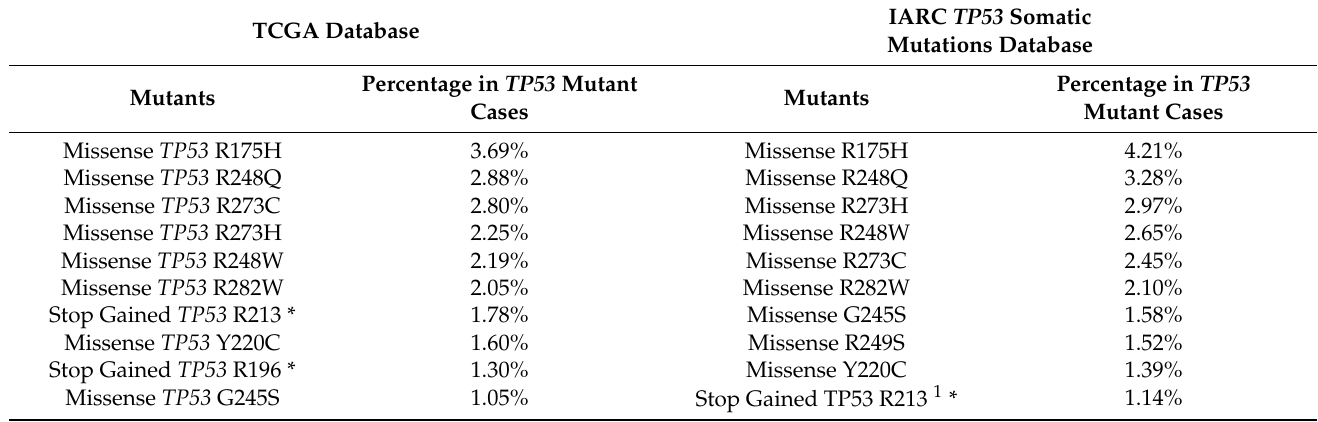
Table 1. Top 10 frequently occurring TP53 mutants. Data were obtained from the TCGA database and the IARC TP53 somatic mutations